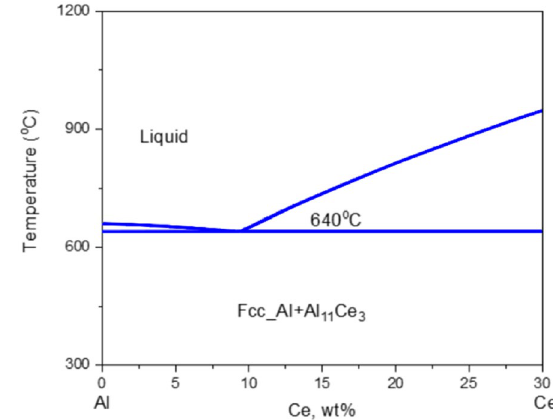
Figure 1. Al-Ce Binary Phase Diagram from 0 to 30